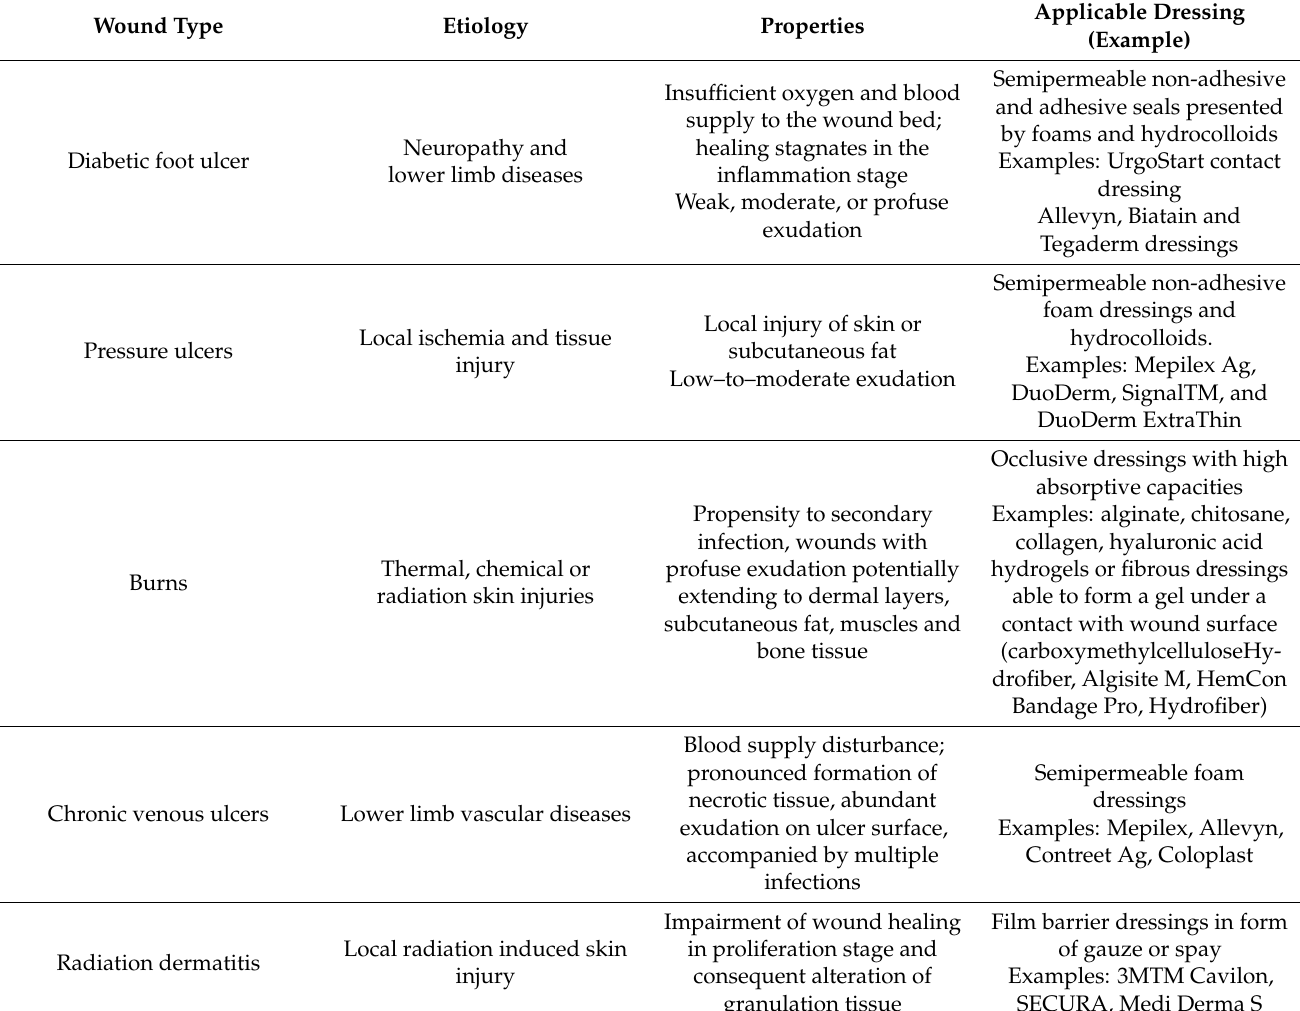
Table 1. Summary of the applicable dressings for mixed etiology chronic wounds (from C.Shi et al., 2020